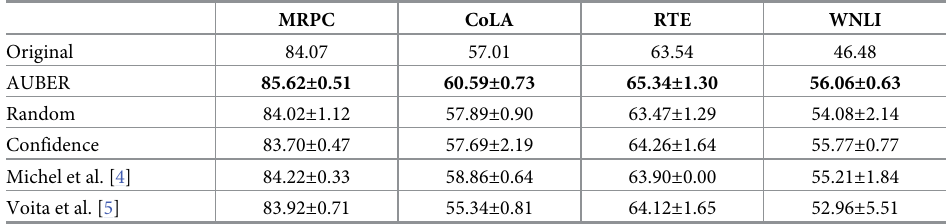
Table 2. Performance of AUBER and its competitors. AUBER gives the best performance for the same number of pruned heads. Bold font indicates the best performance among competing pruning